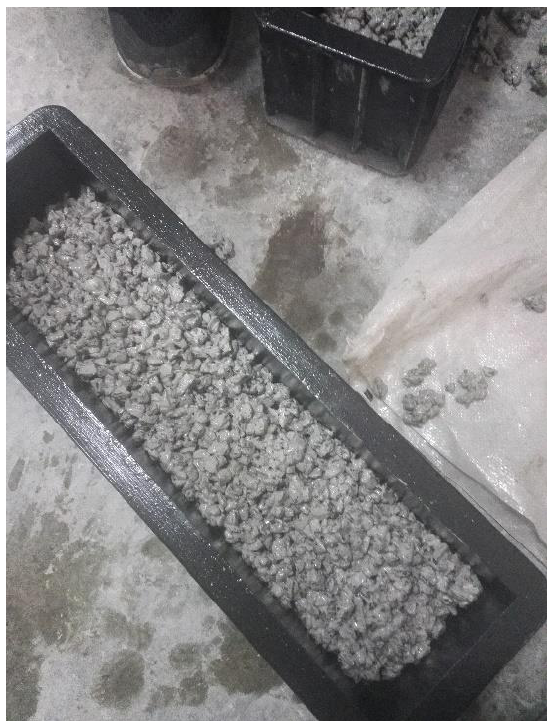
Figure 4. Preparation of tensile strength test specimen.